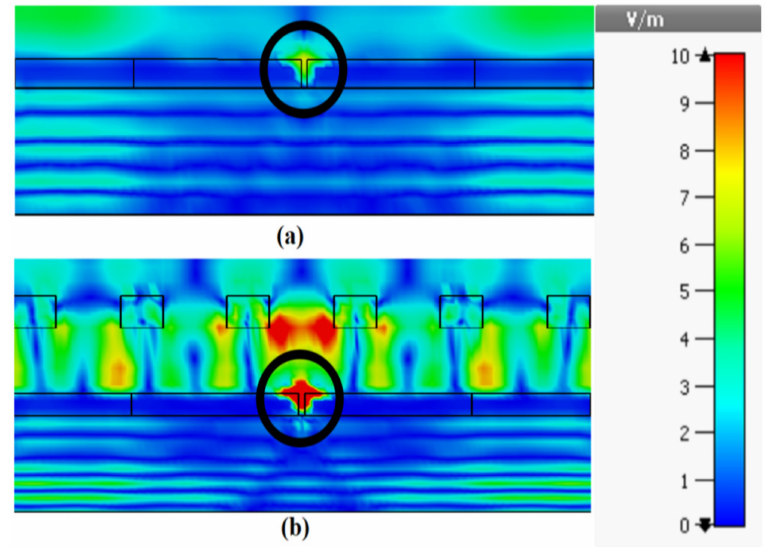
Figure 6. The optical E-field distribution ( a ) without FSS ( b ) with